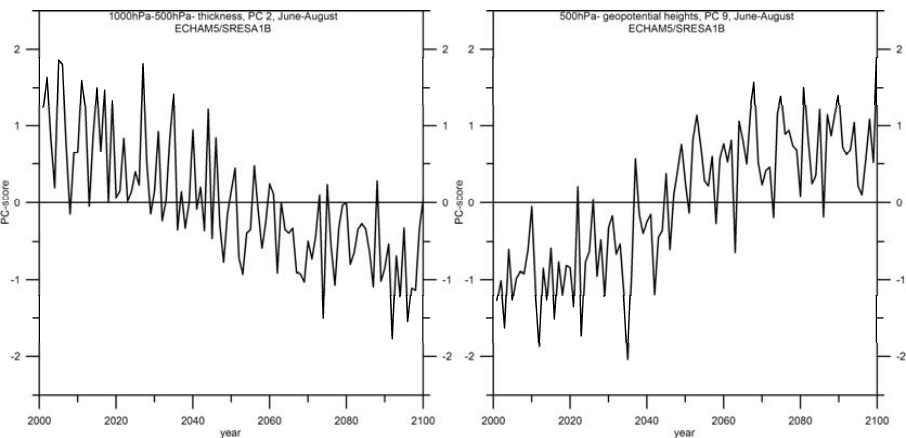
Figure 6: Loadings of PCs which are selected as dominant independent variables in the multiple regression models for extreme maximum temperatures at Lisbon in summer (Location of the station marked by red dot). Upper figure: PC2 from the PCA of 1000hPa- 500hPa-thickness in June to August 1950-2003. Lower figure: PC9 from the PCA of 500hPa- geopotential heights in June to August 1950-2003.